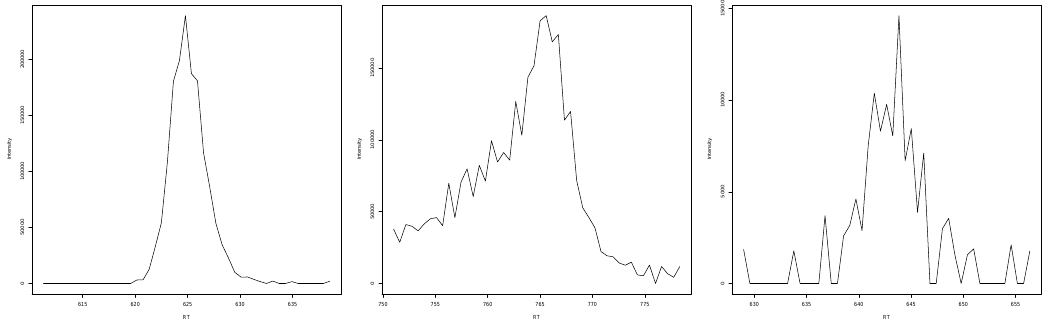
Figure A6. Three examples of EICs that were classified as peaks by all